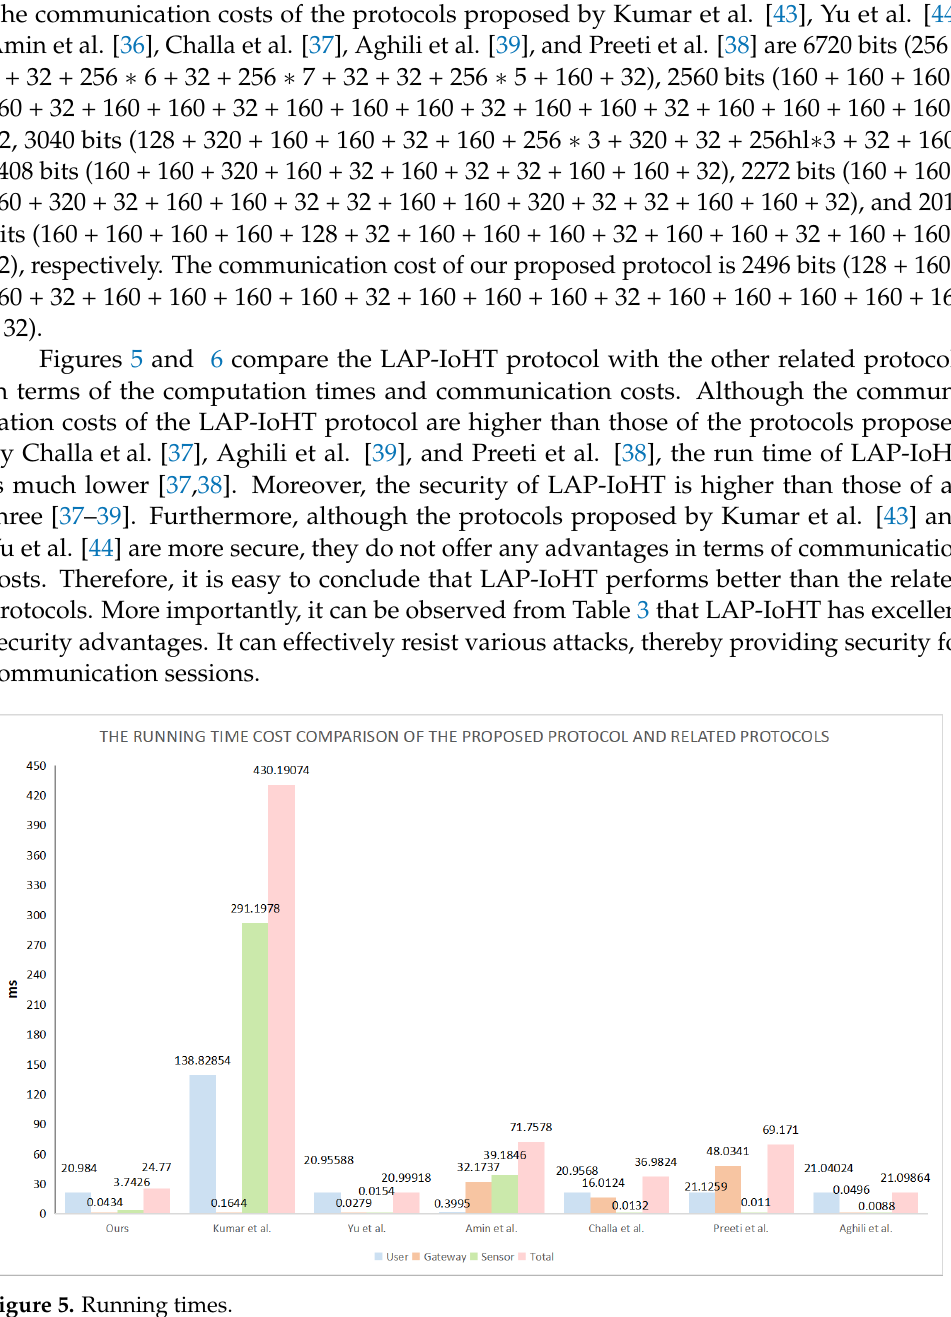
Figure 5. Running